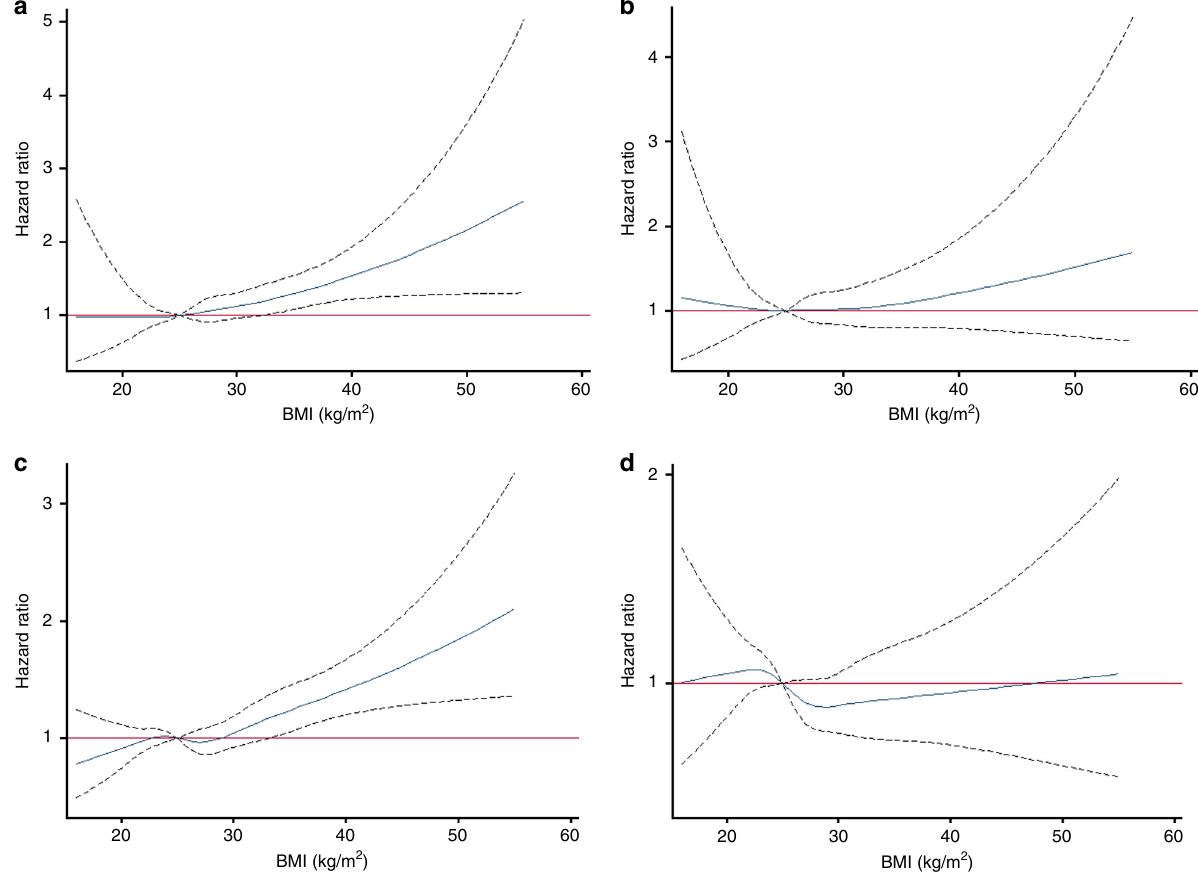
Fig. 1 a Effect of BMI on all-cancer risk among males (989 cancer cases) in the Alberta ’ s Tomorrow Project ( N = 9790) adjusted for covariates. b Effect of BMI on all-cancer risk among males (986 cancer cases) in the Alberta ’ s Tomorrow Project ( N = 9761) adjusted for covariates and continuous waist circumference. c Effect of BMI on all-cancer risk among females (1292 cancer cases) in the Alberta ’ s Tomorrow Project ( N = 15,945) adjusted for covariates. d Effect of BMI on all-cancer risk among females (1287 cancer cases) in the Alberta ’ s Tomorrow Project ( N = 15,886) adjusted for covariates and continuous waist circumference. For ease of presentation, those with a BMI > 55 kg/m 2 were excluded. All models were adjusted for age (continuous), ethnicity (white/other), marital status (married or living with someone/divorced, separated, or widowed/single, never married), highest level of education (high school or less/some post-high school education/post-high school certi fi cate or degree), total household income ($0 – $49,999/$50,000 to $99,999/ ≥ $100,000), geographical area of residence (urban/rural), smoking status (current/former/never), alcohol consumption (grams of ethanol per day), energy intake (kilocalories per day), total physical activity (MET-hours per week), history of diabetes (yes/no), and family history of cancer (yes/no). This fi gure contains the hazard ratio represented by the blue line and the 95% con fi dence intervals represented by the dashed black lines on either side of the blue line. The red line represents the null value of 1 for the hazard Cox proportional hazard); women in the highest versus lowest WHR had a 19% (95% CI: 1.01, 1.41) increased risk of all-cancer quartile of WtHR had a signi fi cantly increased risk of developing during the follow-up period. An increased risk of endometrial all-cancer (HR Q4vsQ1 = 1.31, 95% CI: 1.25, 1.53) and endometrial cancer was observed for females in both the highest and second cancer (HR Q4vsQ1 = 4.19, 95% CI: 2.42, 7.23) during the follow- highest quartiles of WHR (HR Q4vsQ1 = 1.97, 95% CI: 1.09, 3.57; HR Q3vsQ1 = 2.10, 95% CI: 1.17, 3.75). When we examined sex- up period. In a fi nal model additionally adjusted for BMI, a signi fi cantly increased risk of developing endometrial cancer speci fi c fi ndings for quartiles of WHR and cancer risk in sensi- was no longer observed (HR Q4vsQ1 = 1.29, 95% CI: 0.47, 3.49). tivity analyses excluding cancers that occurred < 2 years after baseline data collection, effects estimates were not meaningfully altered (Supplementary Table 6). cancer for males and females combined were further examined Table 7. For males, signi fi cant positive trends were observed by smoking status for BMI, WC, and WHR and these results between increasing WtHR and the incidence of all-cancer are presented in Supplementary Tables 8 – 10. Smoking statuses ( P trend ≤ 0.01, Cox proportional hazard) and colon cancer ( P trend included never smokers, former smokers, and current smokers. = 0.03, Cox proportional hazard) though none of the individual The risk of developing lung cancer during the follow-up period HR estimates for quartiles reached statistical signi fi cance. For increased among former and current smokers (versus never females, signi fi cant positive trends were observed between smokers) but among current smokers, HRs were highest among increasing WtHR and the incidence of all-cancer ( P trend ≤ 0.01, the smallest category of body shape and size (i.e. normal BMI, Cox proportional hazard) and endometrial cancer ( P trend ≤ 0.01, below guidelines for WC, and the lowest quartile of WHR).